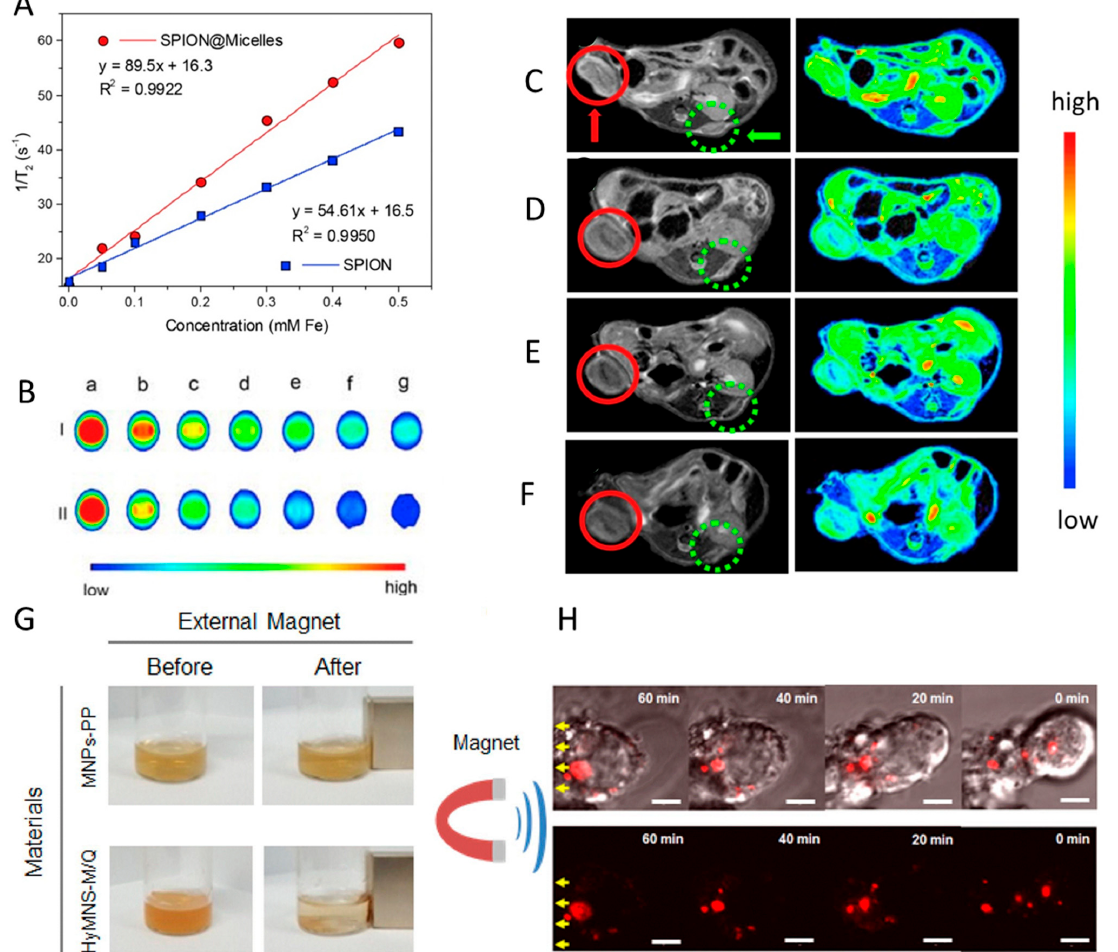
Figure 4. Imaging features of magnetic micelles. T 2 -weight MRI images of SPIONs and SPION@micelles in vitro ( A , B ) and in vivo ( C – F ): ( A ) T 2 relaxation rates as a function of iron (Fe) concentrations; ( B ) T 2 -weight MRI images of SPIONs (I) and SPION@ micelles (II) recorded on a 1.5 T clinical MRI instrument at different Fe concentrations (mM): a, 0; b, 0.05; c, 0.1; d, 0.2; e, 0.3; f, 0.4; g, 0.5; ( C – F ) In vivo T 2 -weighed MR images of HeLa tumor-bearing mice before ( C ) and after intravascular injection of SPION loaded micelles for ( D ) 1 h, ( E ) 3 h and ( F ) 7 h acquired on a 7.0 T MRI instrument. The tumors in the left and right flanks are identified by green dots and red circles, respectively. The magnetic field was applied to the right tumor while the left was not. ( G ) Photos showing the magnetic responses of polymeric micelles incorporating magnetic nanoparticles and quantum dots (HyMNS-M/Q), and magnetic nanoparticles coated with poly(maleic anhydride-alt-1-octadecene)-poly(ethylene glycol) (MNPs-PP) after applying an external magnetic field; ( H ) Real-time image of HyMNS-M/Q migration (yellow arrows) in the cytoplasm of a living cell under the external magnetic stimulus. Scale bar: 3 µ m. Adapted with permission from Refs. [38,89]. Copyright 2022,